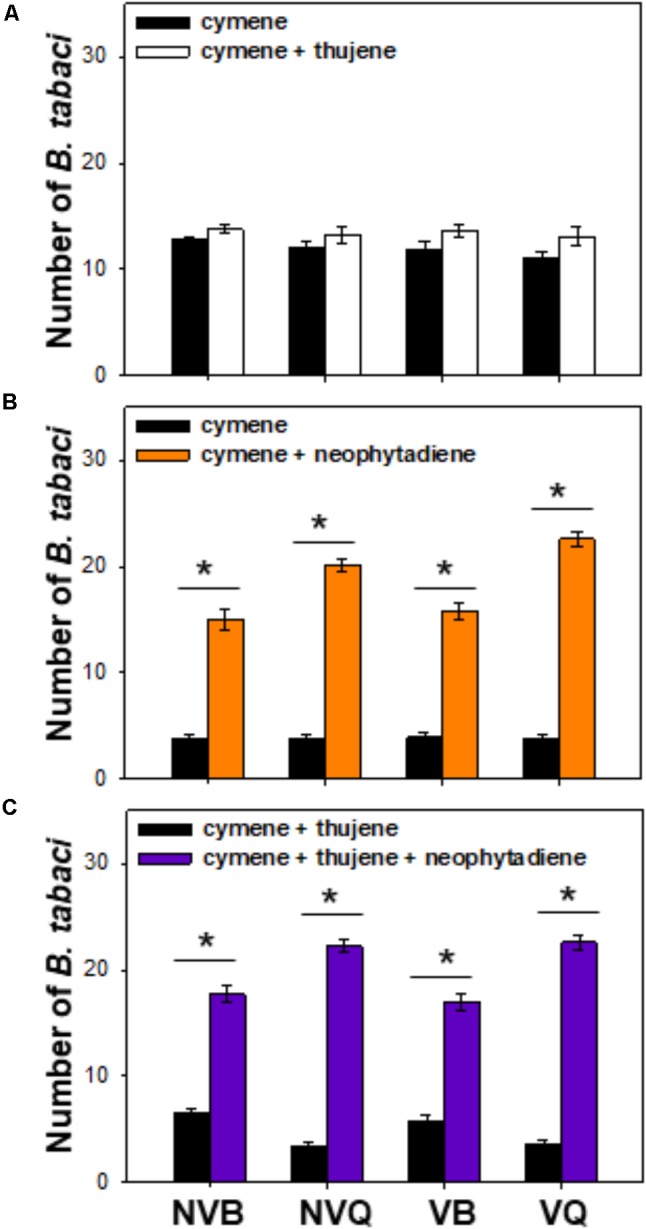
Preference of B. tabaci for plant volatiles with different combinations. Preference of B. tabaci for ρ-cymene vs. ρ-cymene + thujene (A), ρ-cymene vs. ρ-cymene + neophytadiene (B), and ρ-cymene + thujene vs. ρ-cymene + thujene + neophytadiene (C) was investigated using a Y-tube olfactometer. Values are means ± SE (n = 9). Asterisks indicate significant differences (P < 0.05) between two treatments by a general linear model.